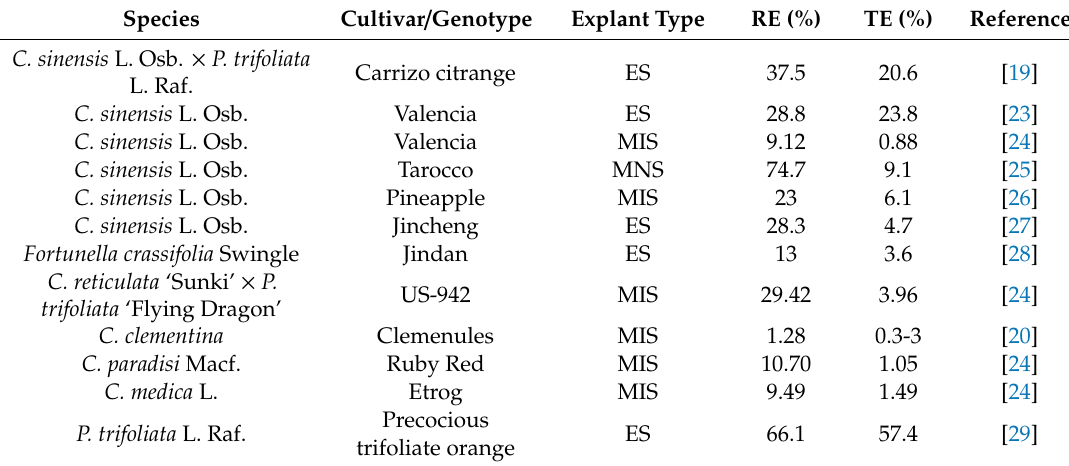
Table 1. Regeneration (RE) and transformation (TE) e ffi ciencies of di ff erent citrus species. Explant types considered are epicotyl segment (ES), mature internode segment (MIS), and mature nodal segment (MNS) with buds